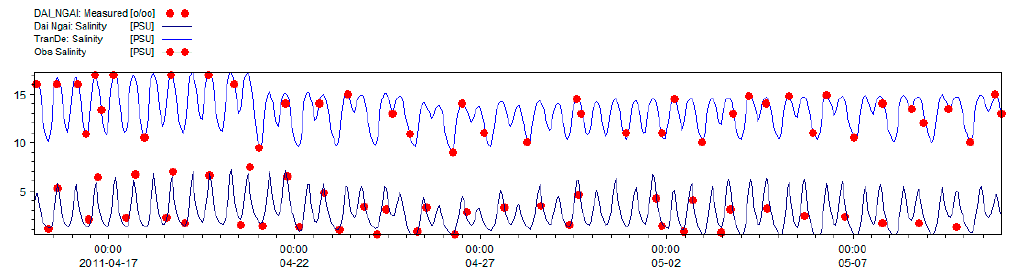
Figure 6. Calibration of salinity concentration at Tran De and Dai Ngai stations.